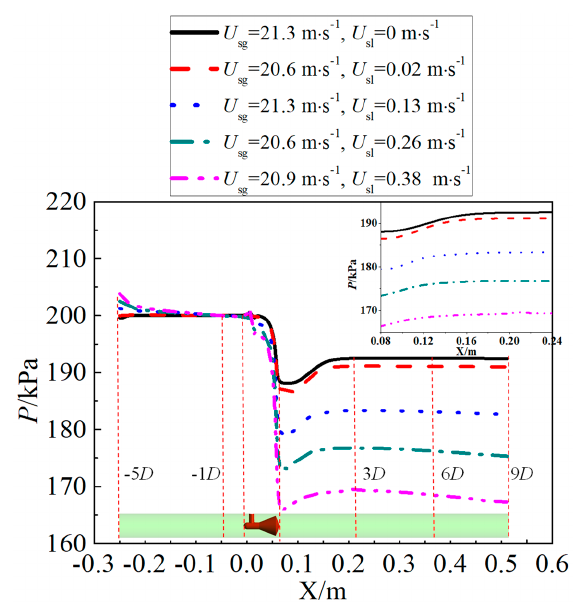
Figure 15. Wall static pressure along flow direction under different superficial liquid velocity.